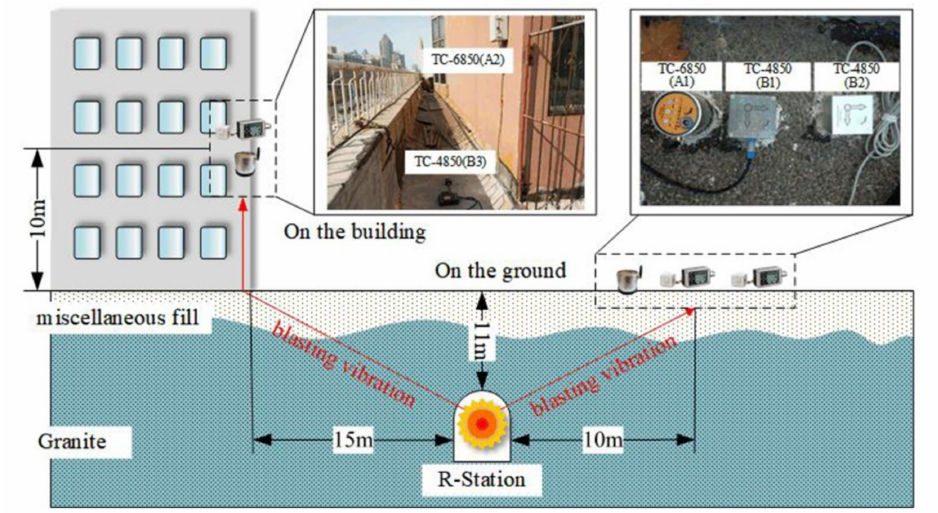
Figure 5. Sensor mounting position diagram of TC-4850 and